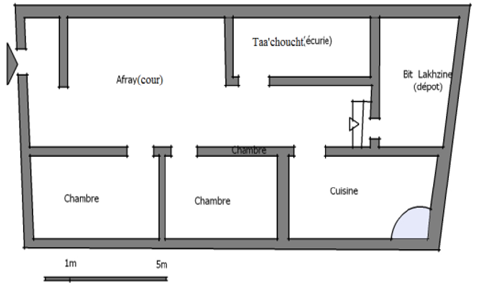
Figure 10. Example of traditional Berber house from Aoughanim . (Authors, 2016).